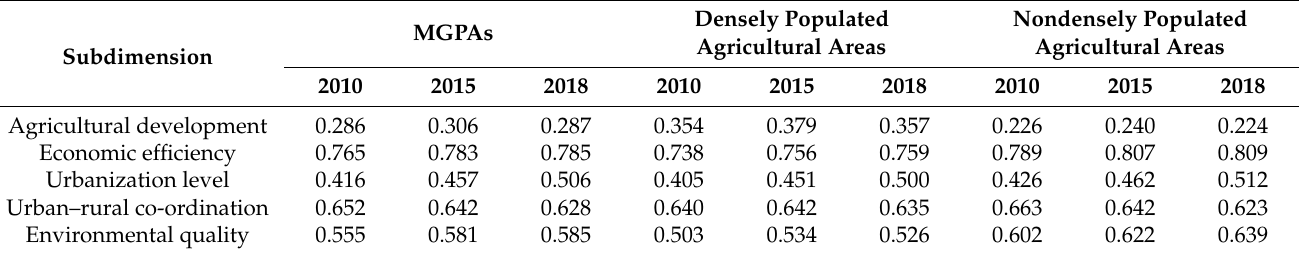
Table 5. Subdimensional quality values in 2010, 2015, and 2018.